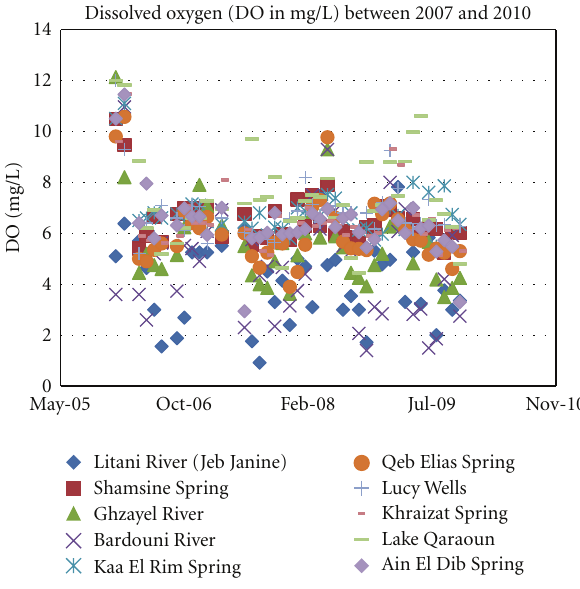
Figure 7: Dissolved oxygen levels for years 2007 through 2010.